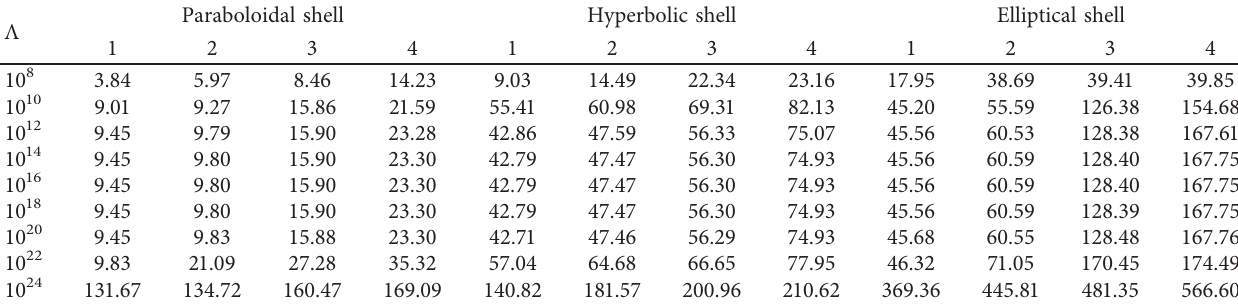
Table 4: Numerical comparison of frequencies for Sandwich FGP doubly curved structure with various boundary conditions. Type